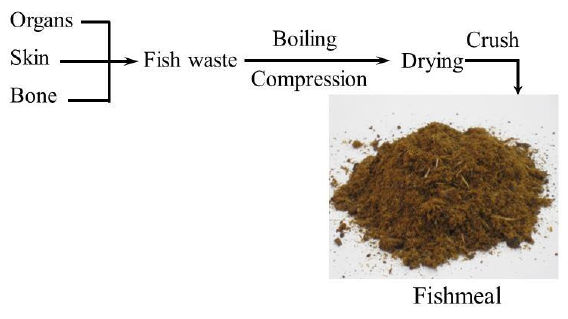
Figure 2. Production of fishmeal.